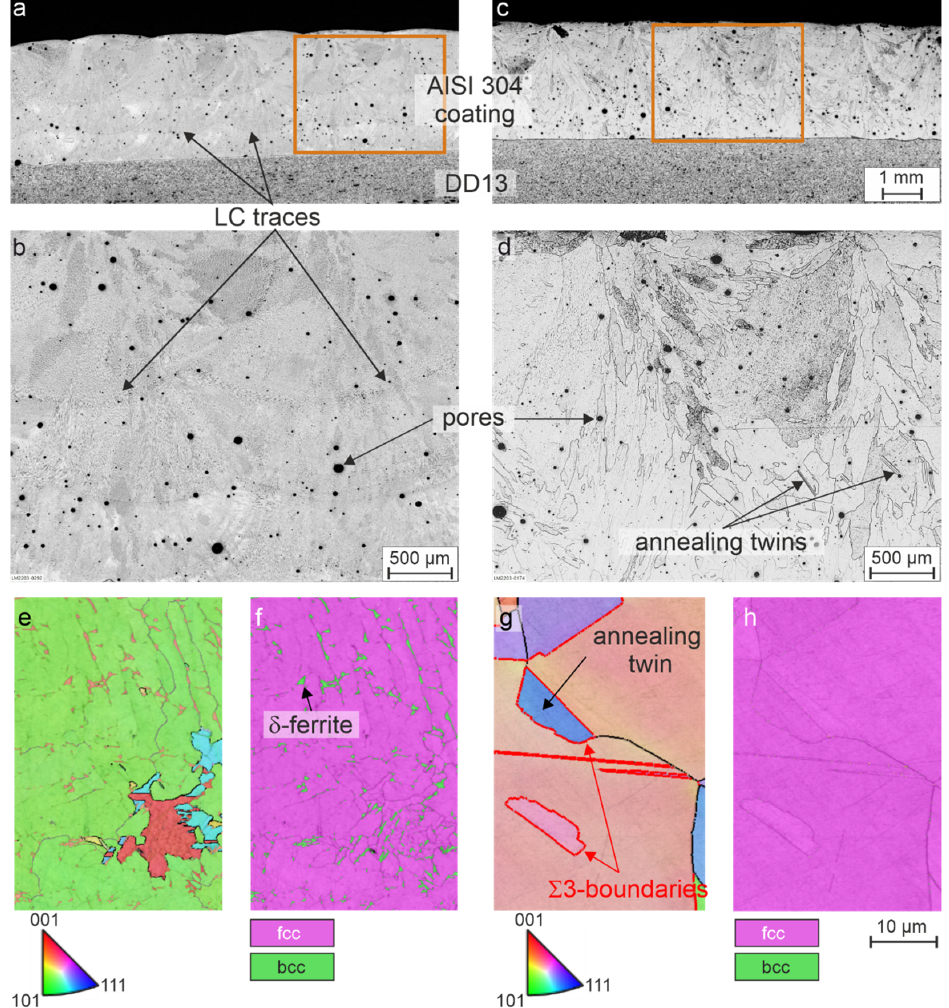
Figure 3. Cross sections of ( a ) coating of AISI 304 in as-cladded condition with ( b ) higher magnification image, and ( c ) after heat treatment at 1,100 °C for 60 min with ( d ) higher magnification image; ( e ) EBSD orientation map of the coating in as-cladded condition with ( f ) corresponding phase map and ( g ) EBSD orientation map of the coating after heat treatment at 1100 °C for 60 min with ( h ) corresponding phase map.